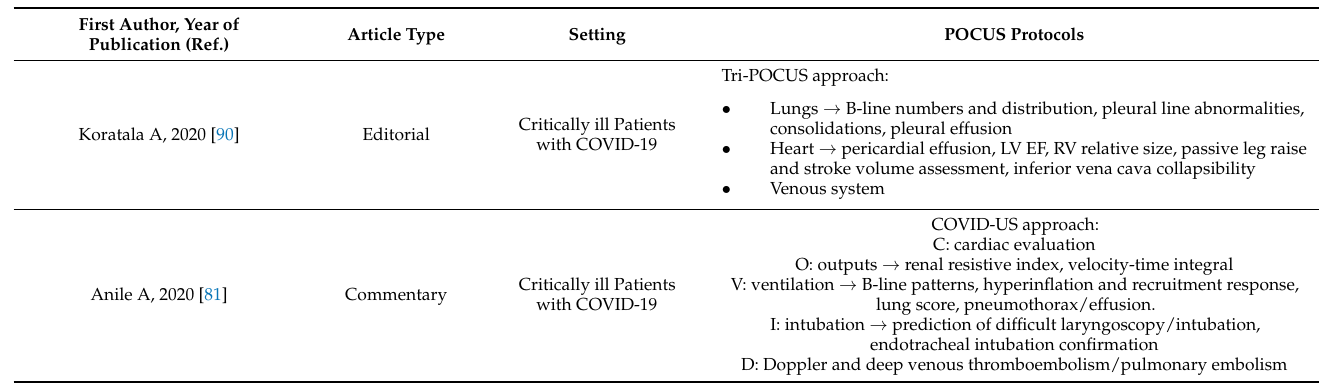
Table 2. COVID-19 comprehensive POCUS